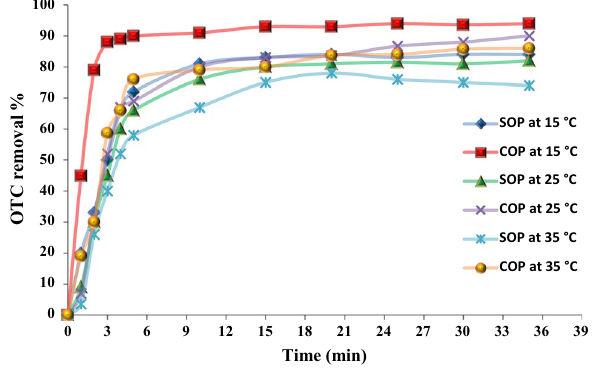
Fig. 10 The effect of temperature with time on the degradation effi- ciency of OTC (OTC conc. = 50 mg/l, pH = 7, ozone generation rate = 1.38 mg/s, ZnO = 100